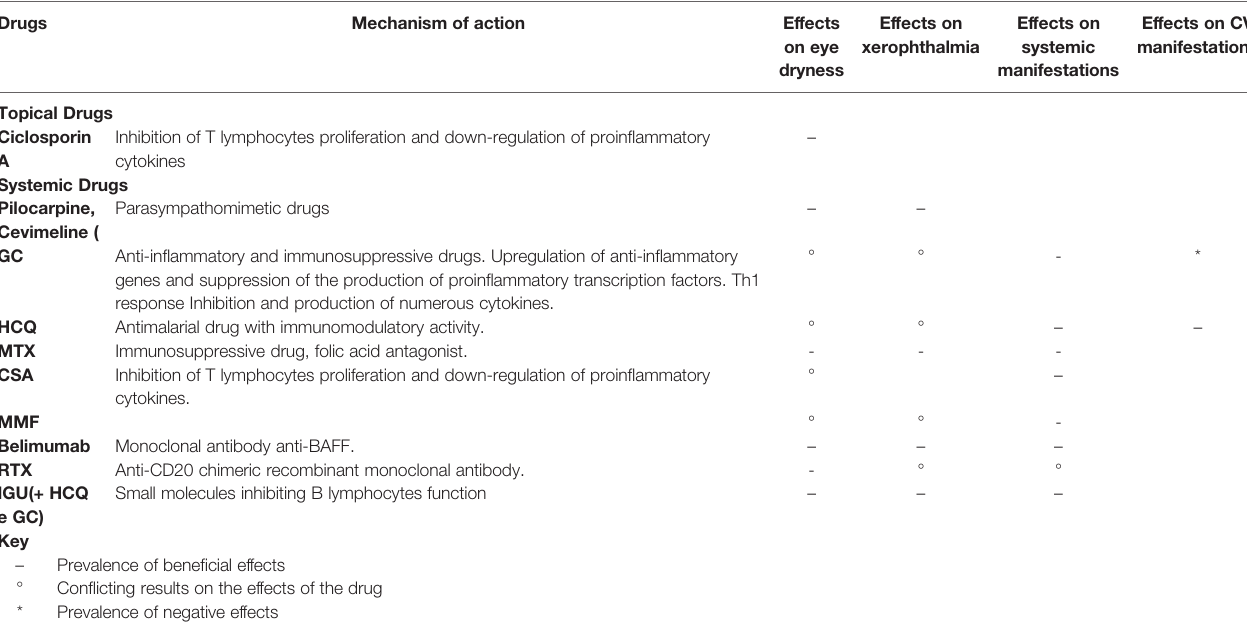
TABLE 1 | The table highlights the ef fi cacy of the drugs most used in the treatment of SS, particularly on eye dryness, dry mouth, systemic manifestations (fatigue, arthralgia/arthritis, pain, and other organ manifestations) and on the main CV manifestations (atherosclerosis and other conditions).